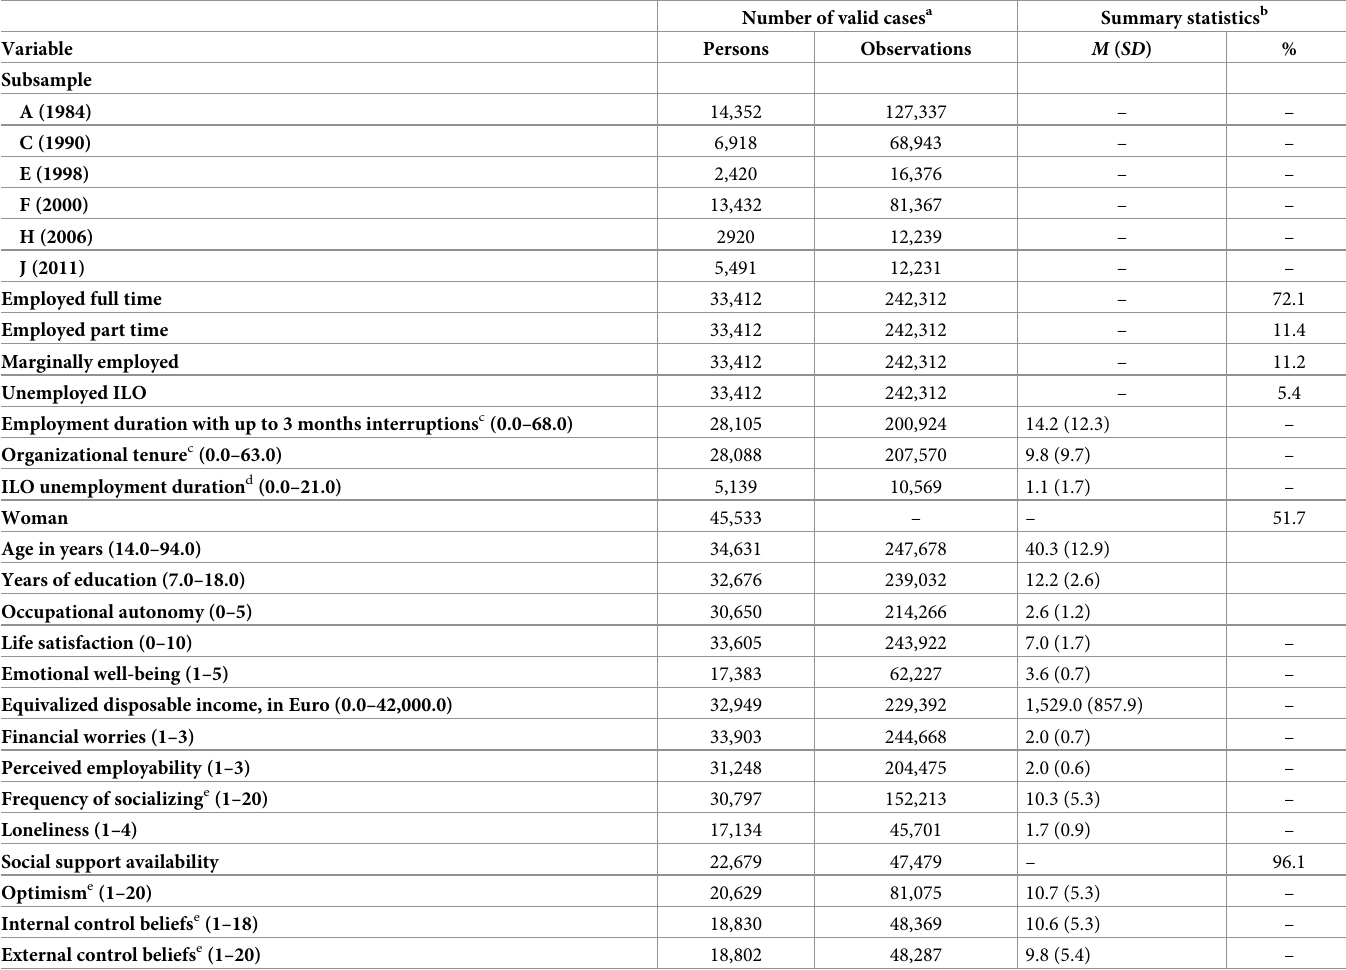
Table 1. Descriptive statistics for the central study